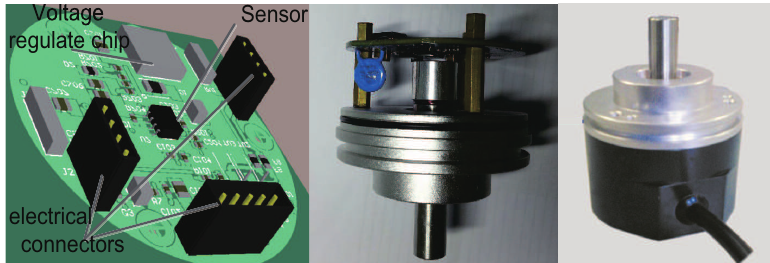
Figure 15. The printed circuit board (PCB) real product